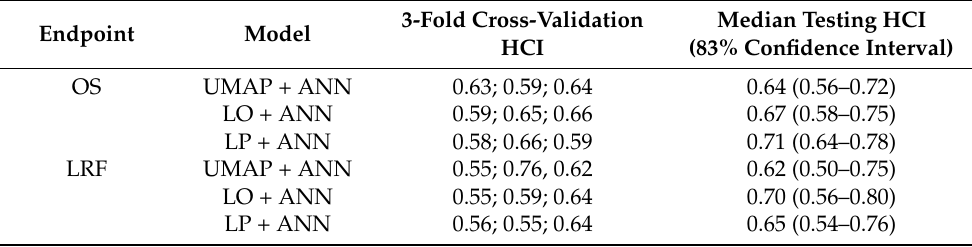
Table 3. Cross-validation and testing results for the different models and endpoints. HCIs shown for the cross validation are the values obtained on each of the sub-folds while for testing we showed the median HCI with confidence intervals obtained from bootstrapping the testing set 1000